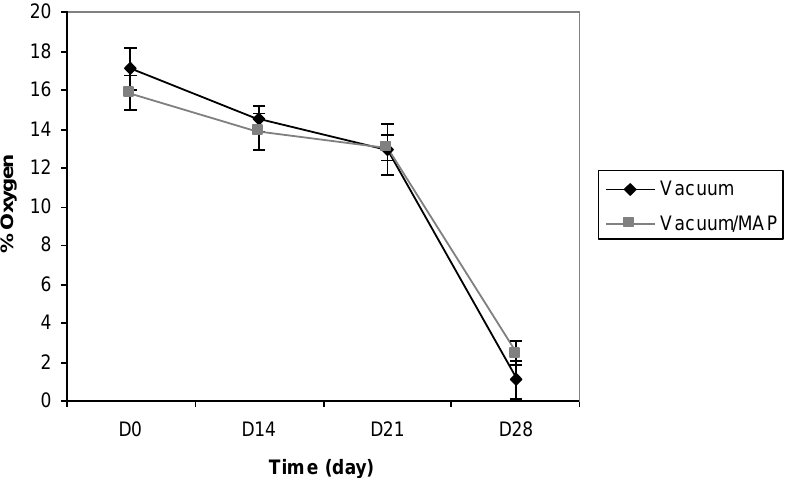
Figure 2. Mean O profiles for battered sausages (BS) packaged under vacuum or 2 packaged under a combination of vacuum and modified atmosphere packaging (MAP); vacuum (0.01 MPa) and vacuum/MAP (0.20/0.06 MPa).